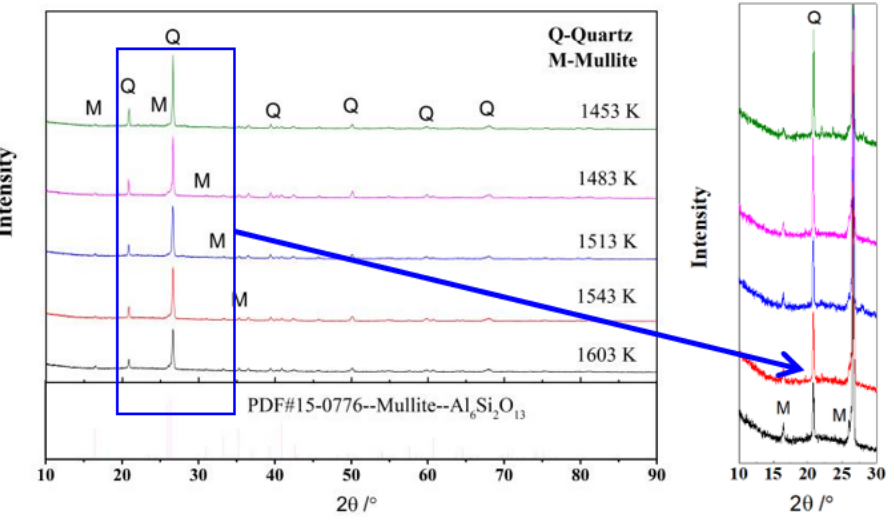
Figure 2. XRD patterns of R at different temperatures. Quantitative analysis (Table 5) showed that the content of anorthite first increased, then decreased at 1513 K, and finally disappeared at 1543 K in M; with increasing